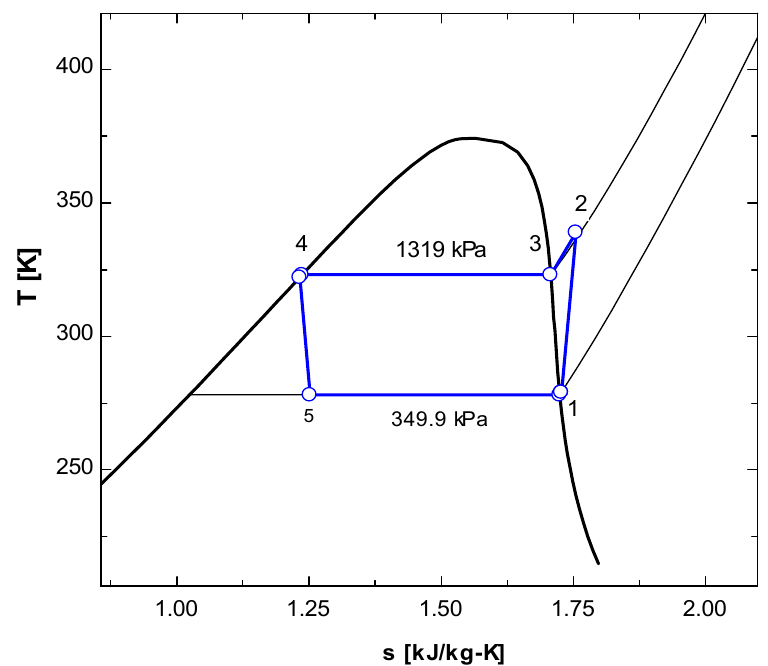
Figure 2 . T-s diagram of vapor compression refrigeration cycle running with R134a .